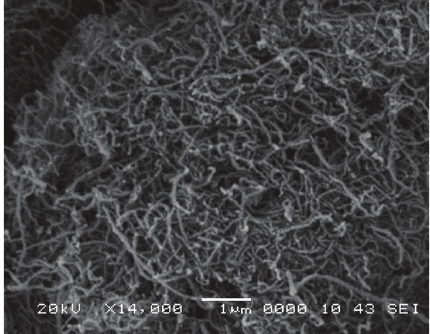
Figure 2: SEM micrographs of carbon